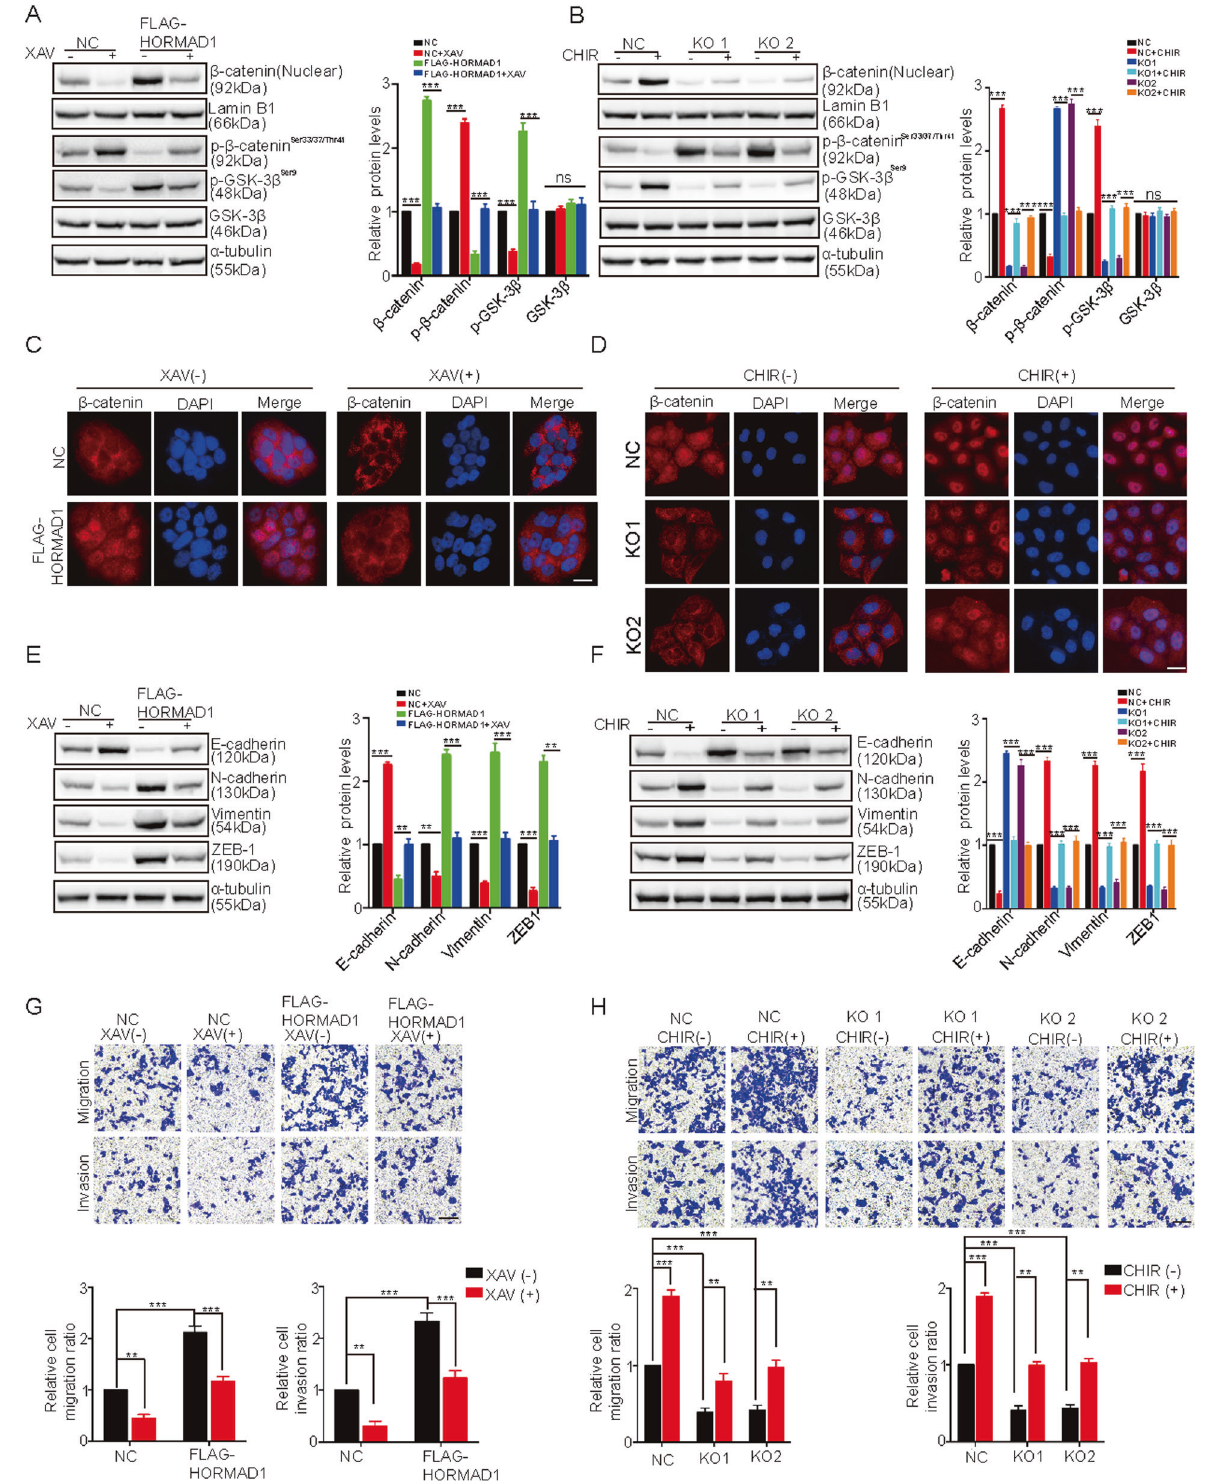
colleagues predicted previously that HORMAD1 and other genes correlate with lung metastasis in breast cancer [37]. However, no study has yet attempted to investigate functional participation of HORMAD1 in lung cancer metastasis. In this study, our results revealed that HORMAD1 promotes tumor growth and metastasis in vivo using xenograft models and models of liver and lung